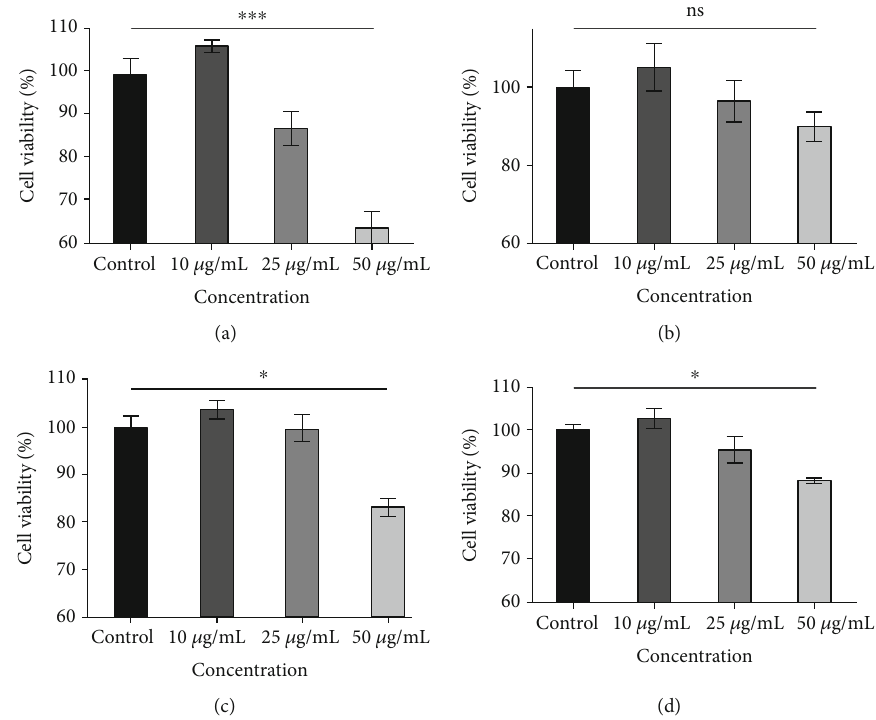
Figure 7: Cell viability using CellTiter 96® AQueous technique of PWR-1E line after (a) 48 and (c) 72h and PC-3 line after (b) 48 and (d) 72h, exposed to Cs-Al NDs. Signi fi cant di ff erence with control: ∗ p < 0 : 05 , ∗∗ p < 0 : 01 , and ∗∗∗ p < 0 : 001 . ns=no signi fi cant di ff